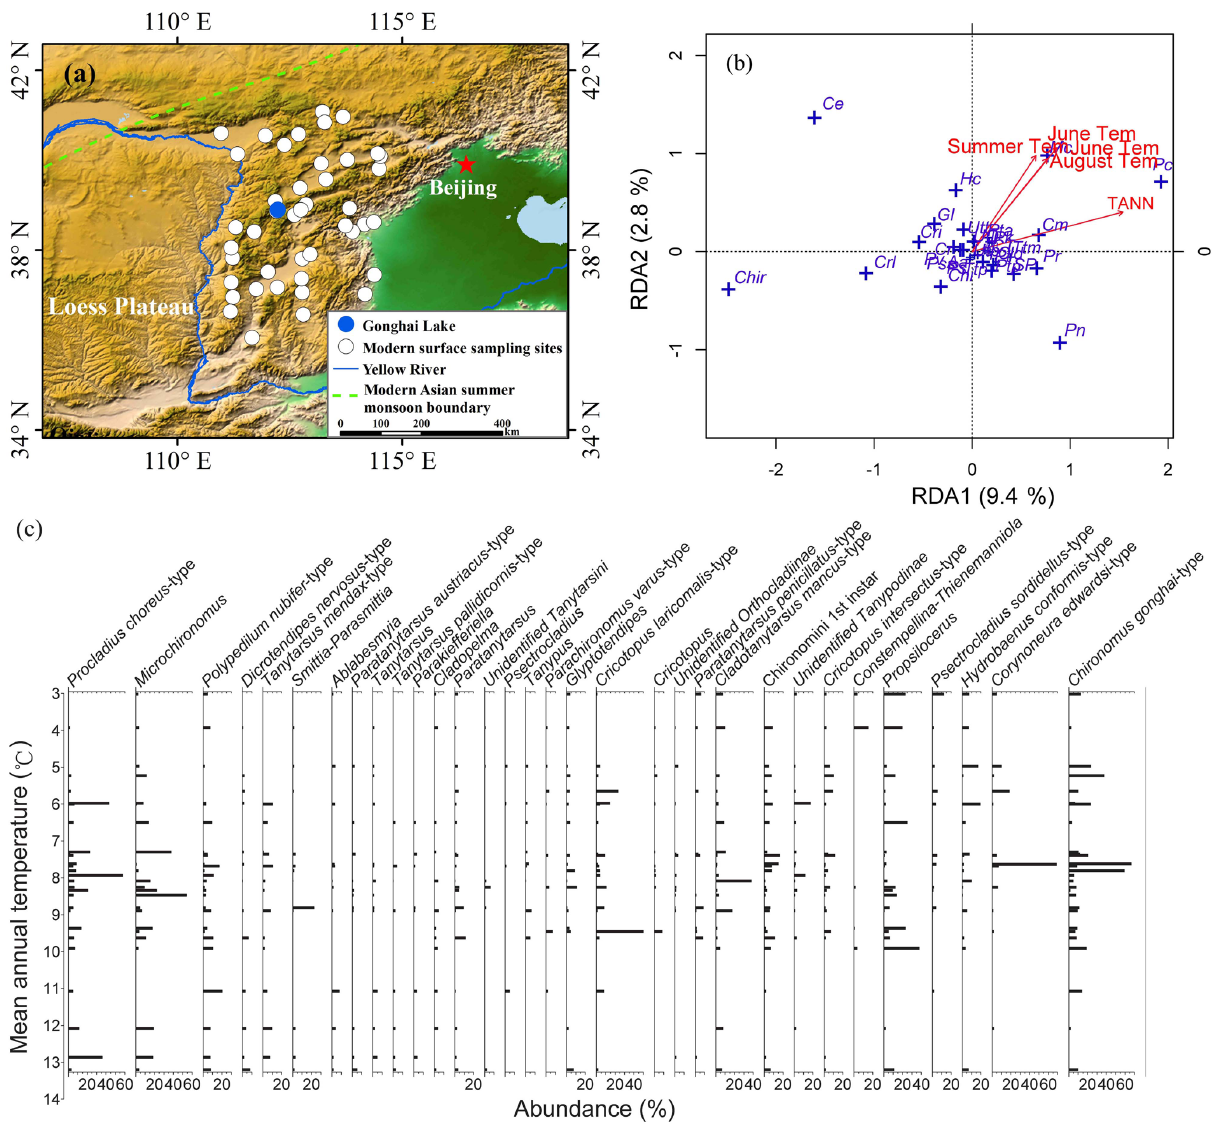
Figure 3. Information about the modern calibration data set obtained from the Gonghai Lake area. (a) Location of modern surface samples (white dots); (b) RDA bi-plot of modern chironomid assemblages and TANN, summer temp, June temp, July temp and August temp; and (c) relative abundance of modern chironomid assemblages from the modern calibration set (Wang et al., 2016). All taxa are arranged according to their RDA 1 scores of chironomids and TANN. Only taxa occurring in at least two samples with an abundance of > 2% are